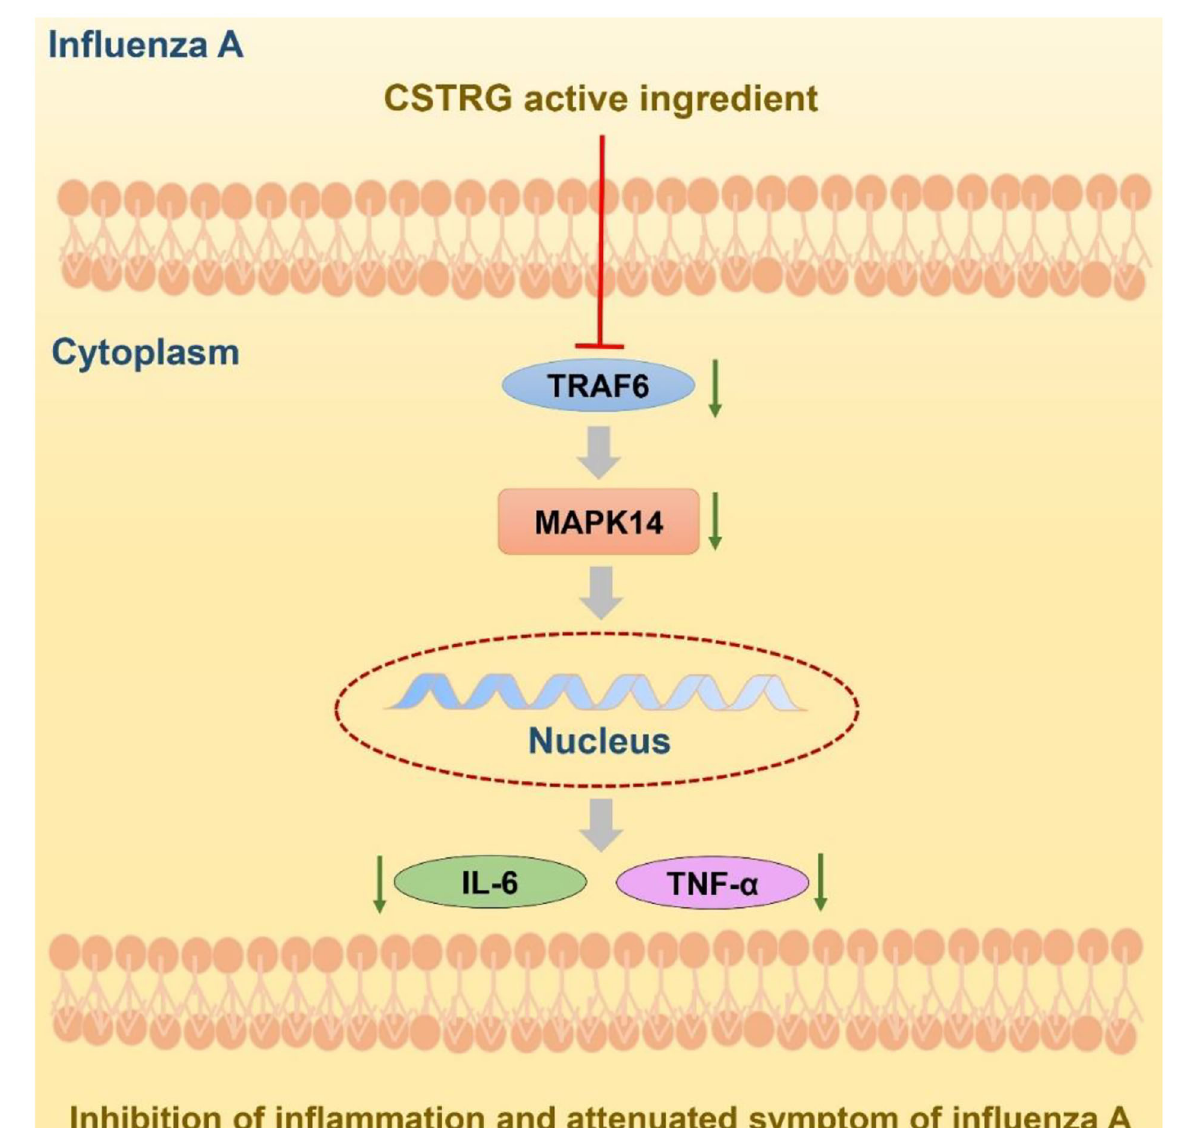
FIGURE7 Potential model of CSTRG treating influenza virus infection through suppressing both virus replication and viral-induced cytokine storms via regulating the TRAF6/MAPK14